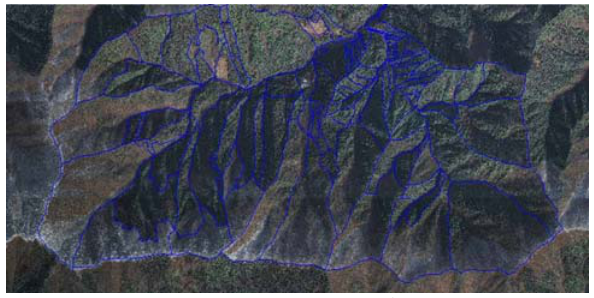
Figure 11. Aerial Photograph used for Experiments